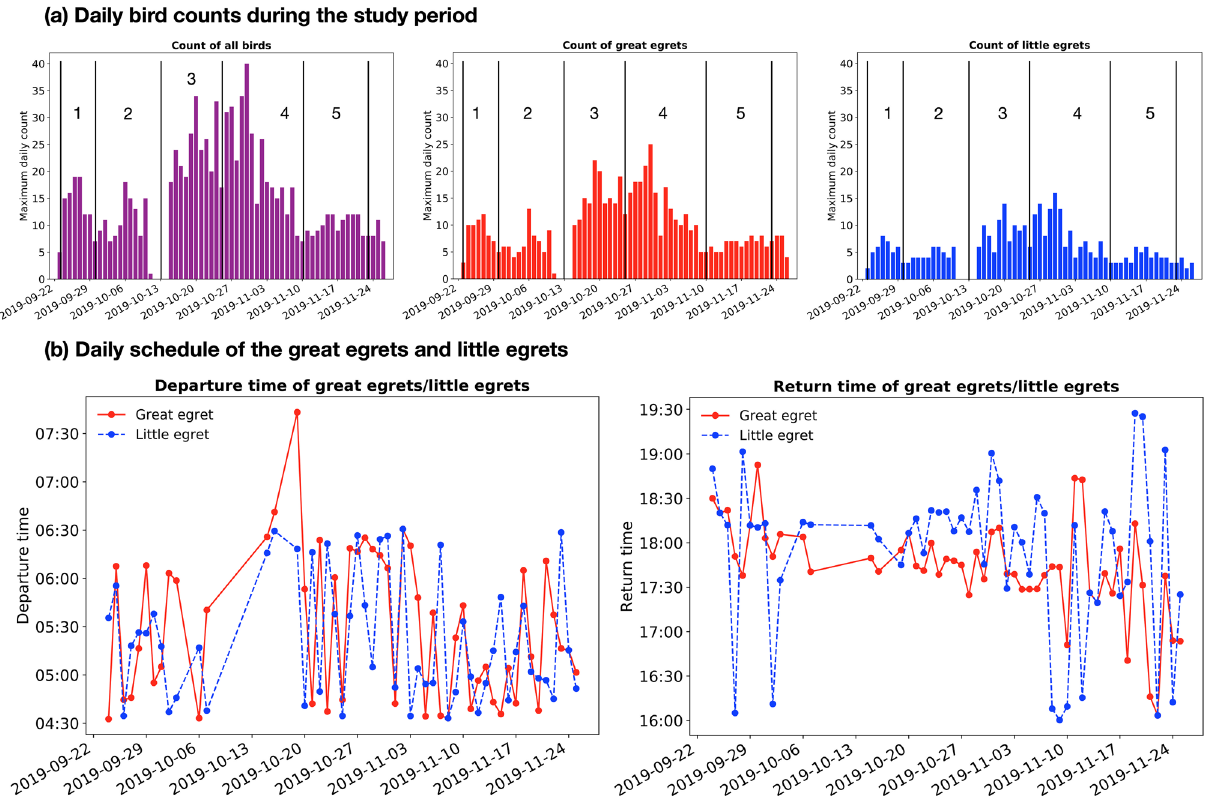
Figure 6. Analyses of the egret behaviour from the temporal perspective: ( a ) Daily bird counts during the study period. The bar graphs show the counts of all birds, great egrets and little egrets. We observe the bird counts increase from 2019-09-23 to 2019-09-27 and then decreases from 2019-09-27 to 2019-09-30. Such a trend repetitively occurs at the periods 2019-09-30–2019-10-13, 2019-10-13–2019-10-25, 2019-10-25–2019- 11-10 and 2019-11-10–2019-11-23. All these sub-periods are separated with black lines in the figure. We also realize a surge in bird counts between the end of October and the beginning of November, which is believed to be attributed to the presence of migratory population; ( b ) Daily schedule of the greats and little egrets. The departure and return time of the egrets are estimated from the peak hourly counts in the morning and evening,